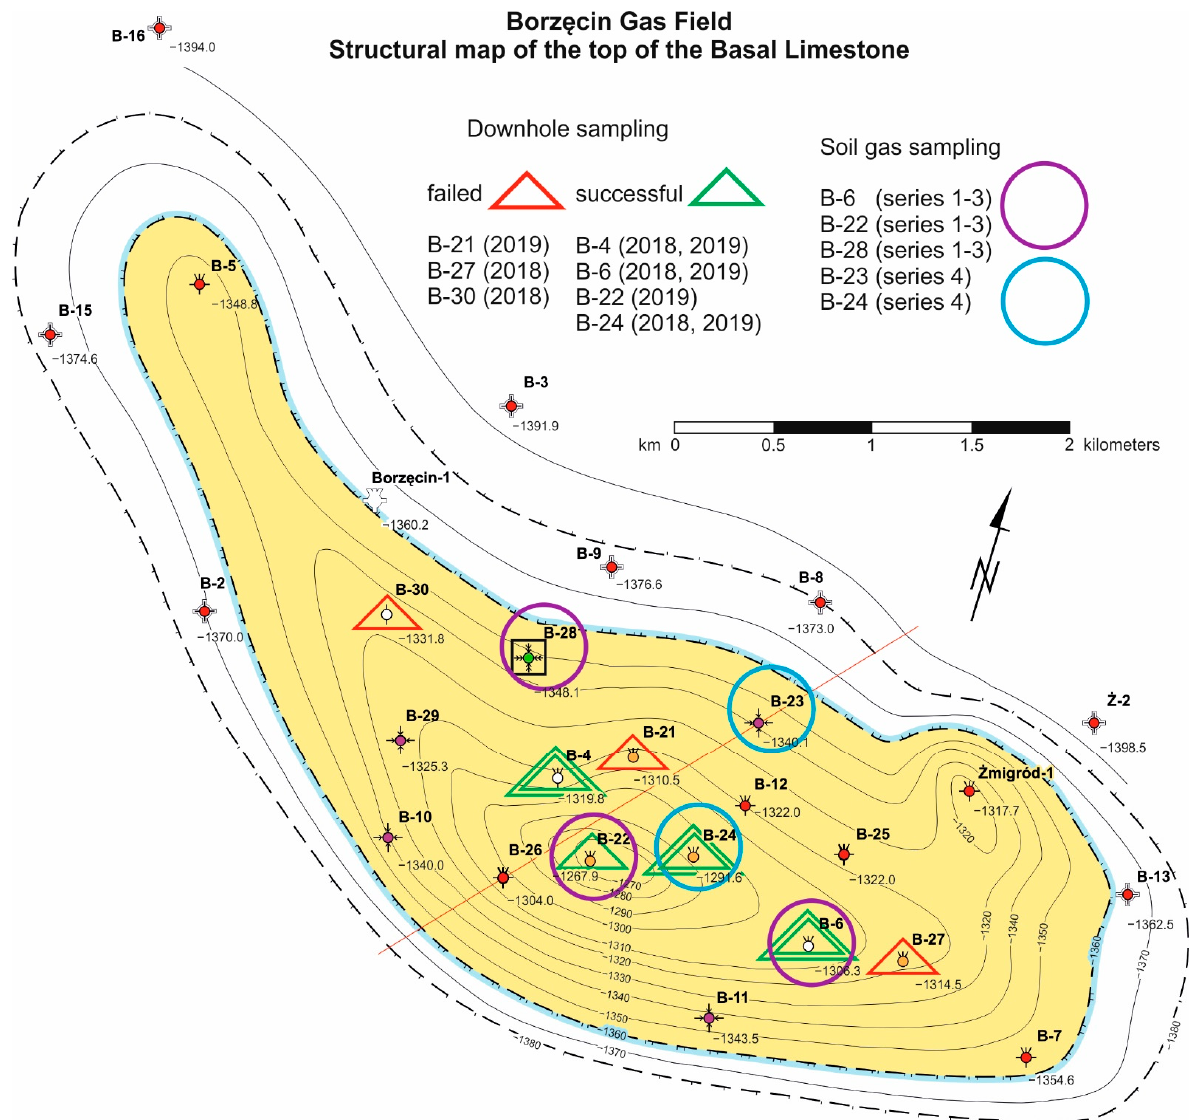
Figure 2. Map of Borz ę cin reservoir—sampling activities